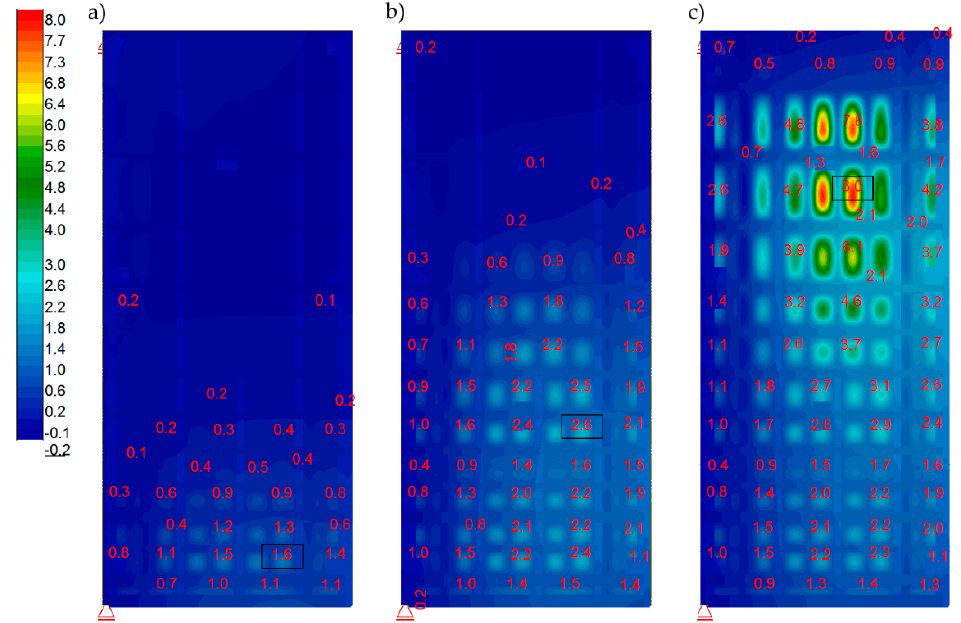
Figure 17. Calculated displacements [mm] at water thrust direction for respective loads. ( a ) B1; ( b ) B2; ( c ) B3.